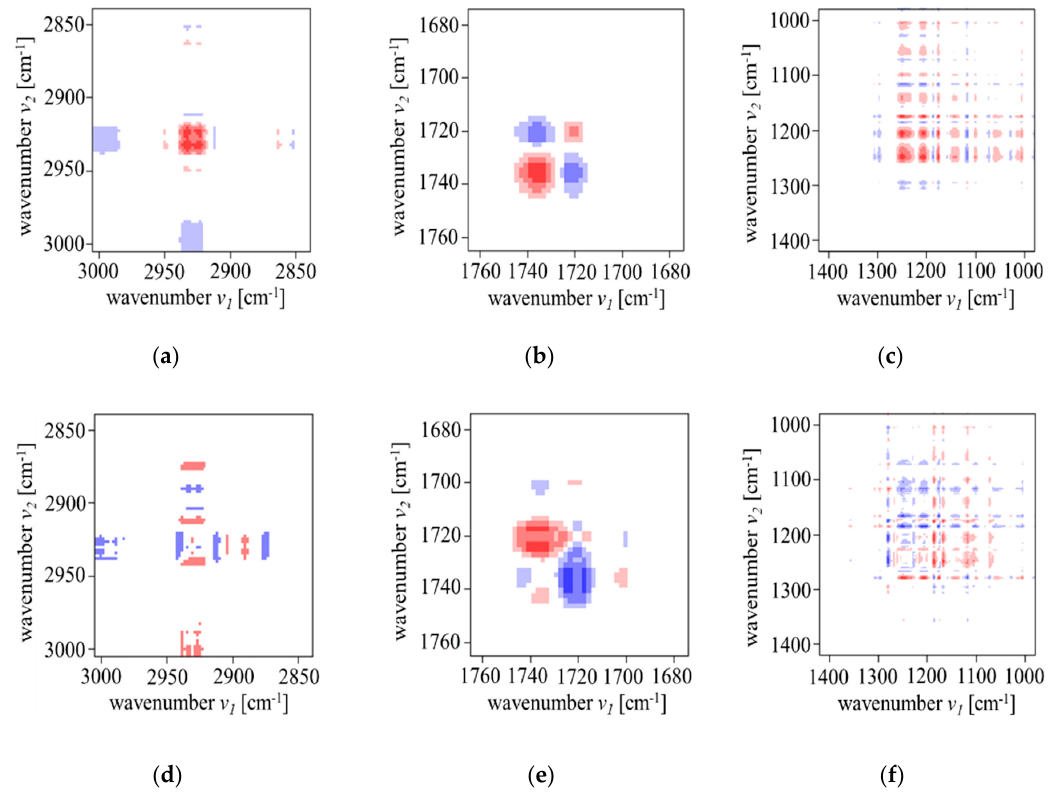
Figure 10. 2D-COS correlation ( a – c ) synchronous and ( d – f ) asynchronous maps of 3F7HPhH7 in the heating mode from 249 to 299 K in the wavenumber regions of: ( a , d ) 3000–2840 cm − 1 , ( b , e ) 1770–1670 cm − 1 and ( c , f ) 1400–1000 cm − 1 . The red or blue areas represent positive or negative correlation intensities, respectively.